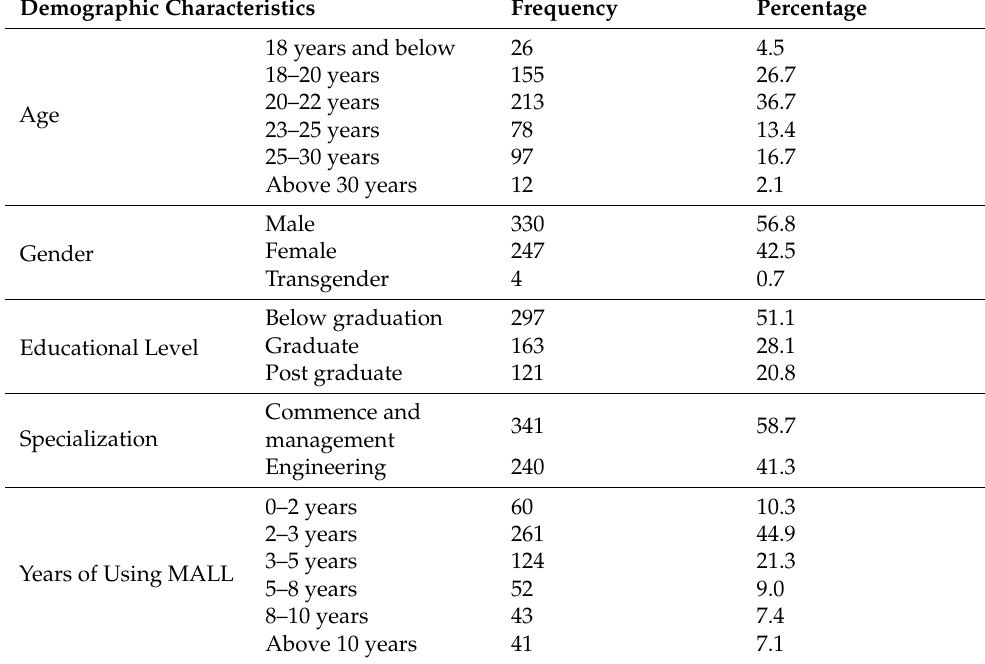
Table 1. Demographic profile of respondents (N =